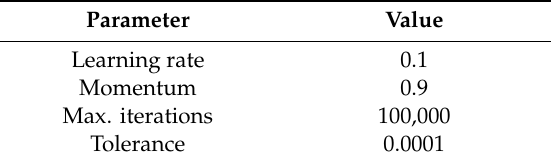
Table 3. Parameters for Multilayer Perceptron (MLP) calculation for all